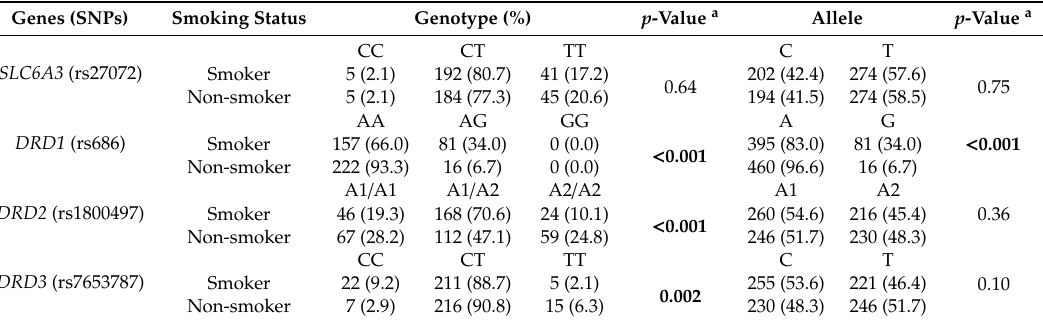
Table 1. Genotype and allele frequencies of SLC6A3 (rs27072), DRD1 (rs686), DRD2 (rs1800497)